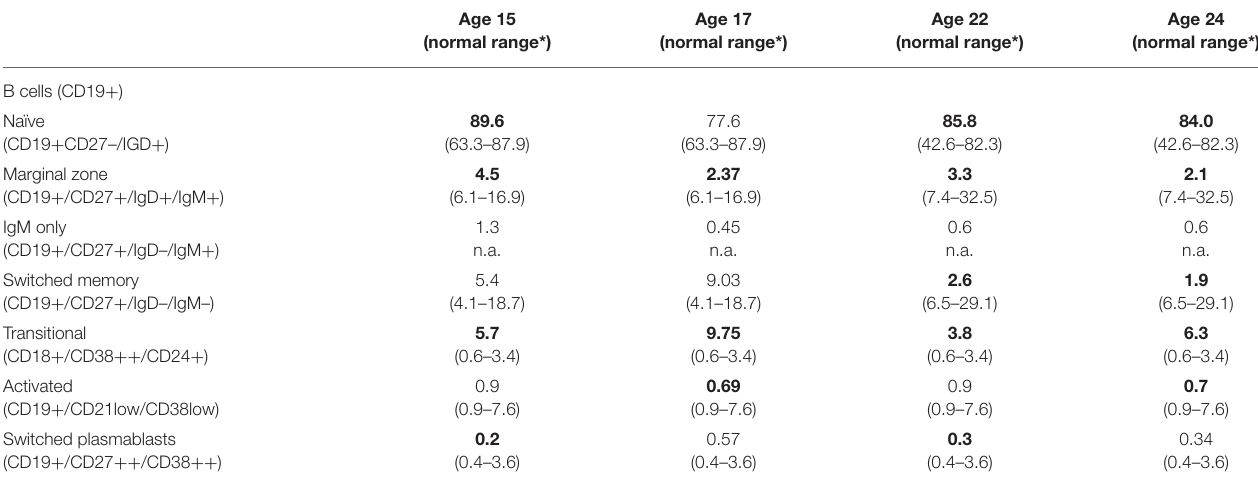
TABLE 1C | B cell subsets at the age of 15, 17, 22, and 24 years.